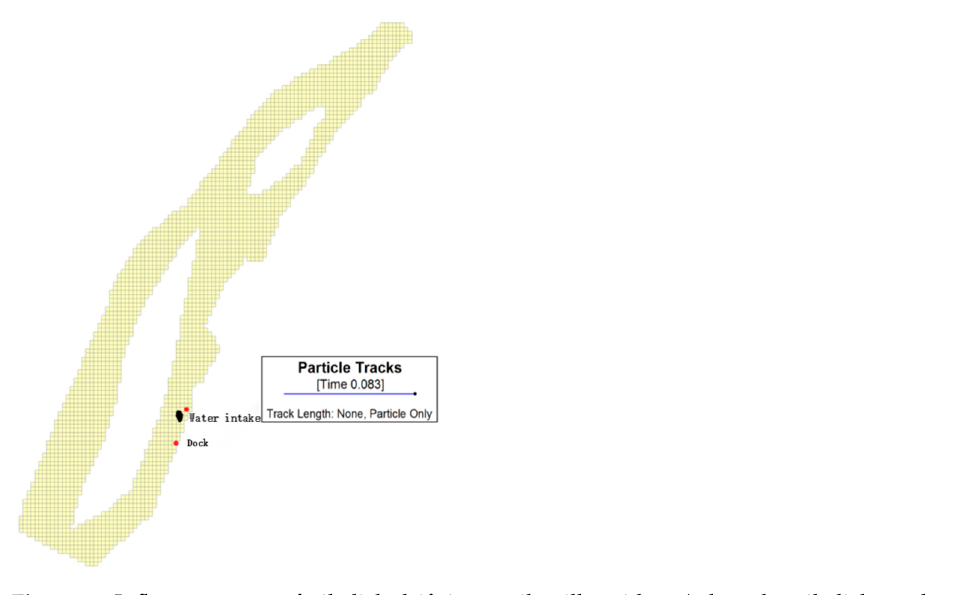
Figure 5. Influence range of oil slick drift in an oil spill accident (when the oil slick drifts out of the water intake). It can be seen from the prediction results that, under the design’s hydrological con- ditions, once accidental leakage occurs, because the water intake is close to the wharf, it will affect the water intake of the water plant sooner and the water quality of the intake will be greatly affected. However, the duration of the impact is relatively short, and the influence time on the proposed water outlet is about 20 min. The impact is greatly weak- ened after the floating oil slick passes through the water intake section. 3.3. Oil Spill Risk Assessment of Terminal Accidents